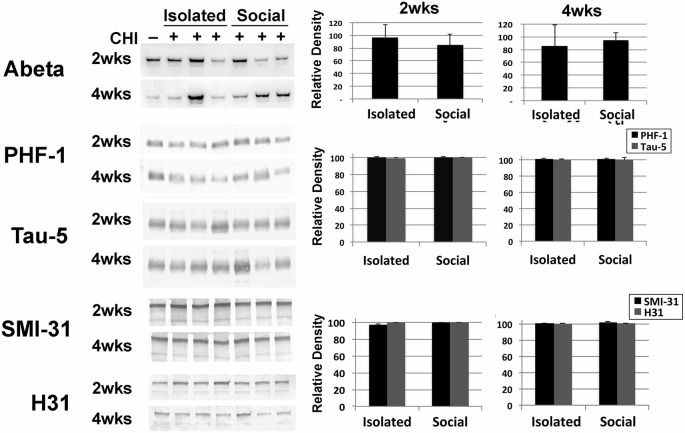
CHI did not alter levels of Abeta, or levels or total or phosphorylated tau or, neurofilaments. Panels present representative immunoblots of brain homogenates from uninjured mice and mice 2 and 4 weeks after CHI probed with anti-Abeta, PHF-1 and Tau-5 (directed against phospho-tau and total tau, respectively) and SMI-31 and H31 (directed against phospho-NF-H and total NF-H, respectively). The accompanying graphs present densitometric quantification; values represent the mean ± standard error from 3 homogenates (each assayed in duplicate) each from each condition as a percentage of levels observed prior to CHI. Additional immunoblots were probed with an antibody (DM1A) directed against alpha- tubulin as a loading control (not shown). Levels of these proteins were unchanged following CHI.